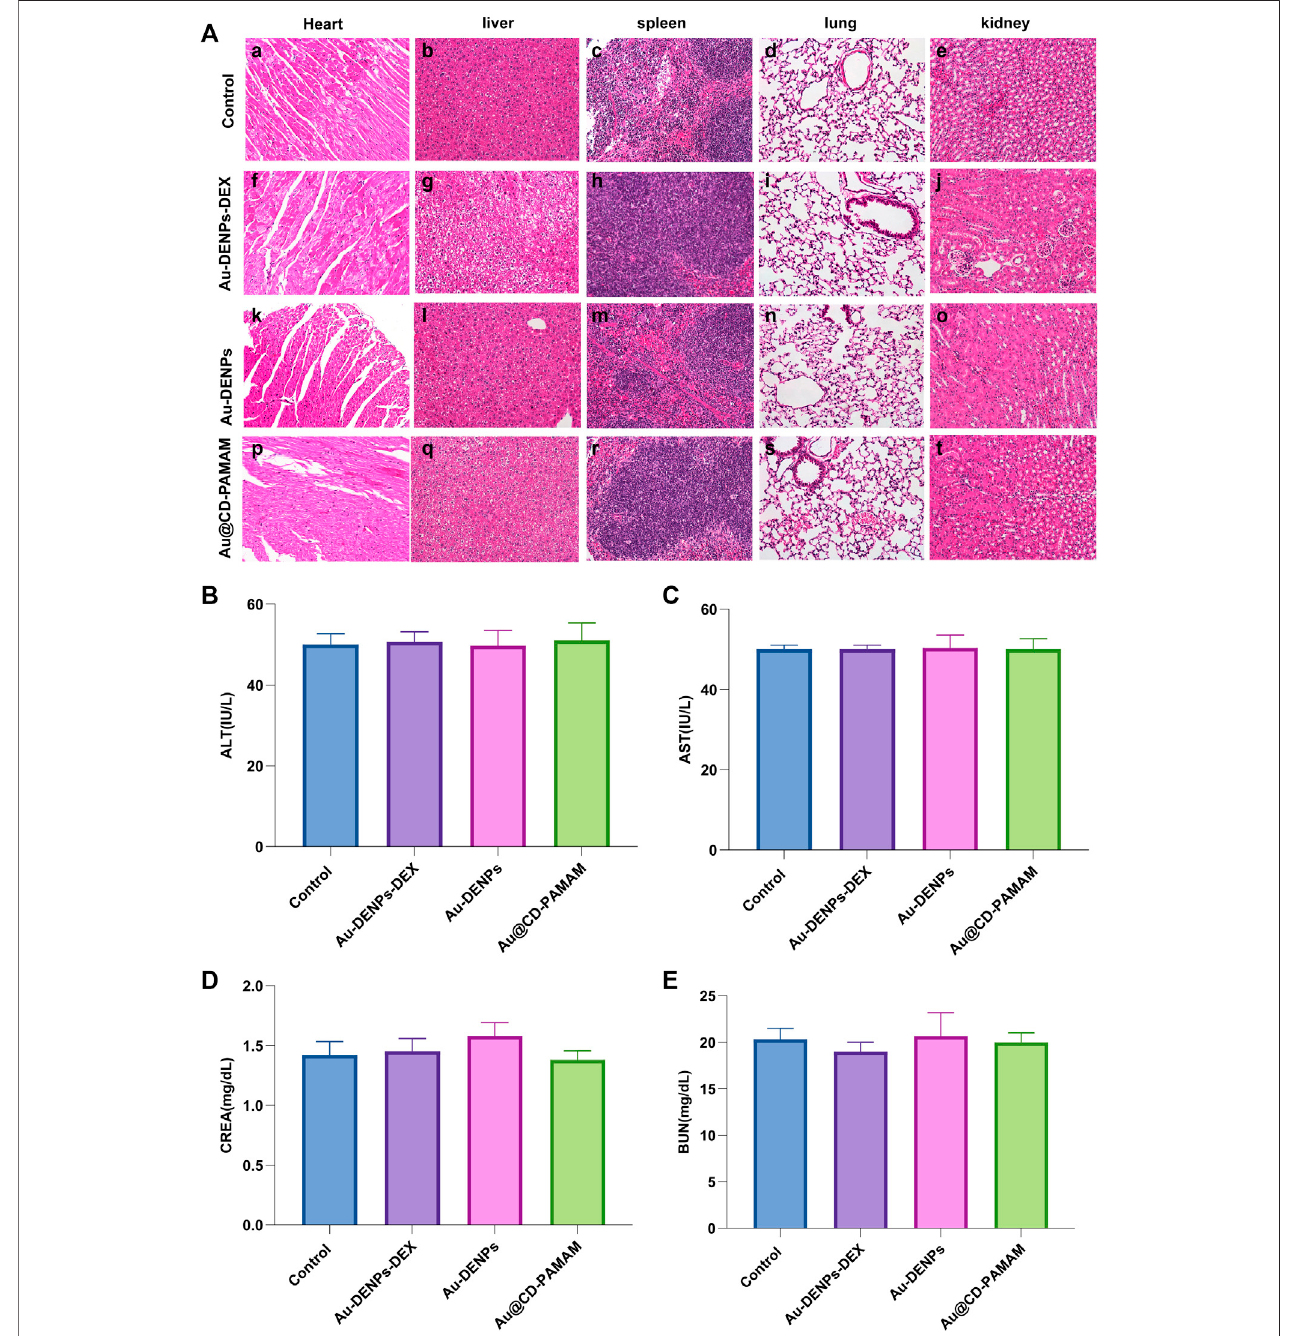
FIGURE 7 | (A) Systemic biosafety assessment. H&E staining of the heart, liver, spleen, lung, and kidney of mice from each group 2 weeks after treatment. Scale bar = 100 μ m. Assessment of acute toxicity effects of (B) ALT, (C) AST, (D) CREA, and (E) BUN of each group ( n = 3 per group).